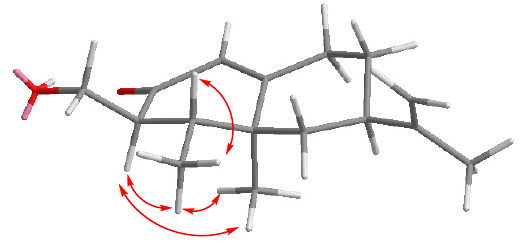
Figure 4. Selected NOEs observed for compound 18.